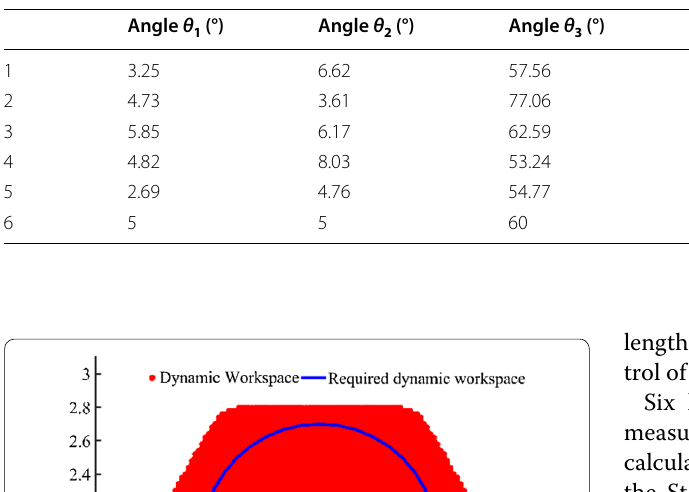
Table 3 Optimal solutions